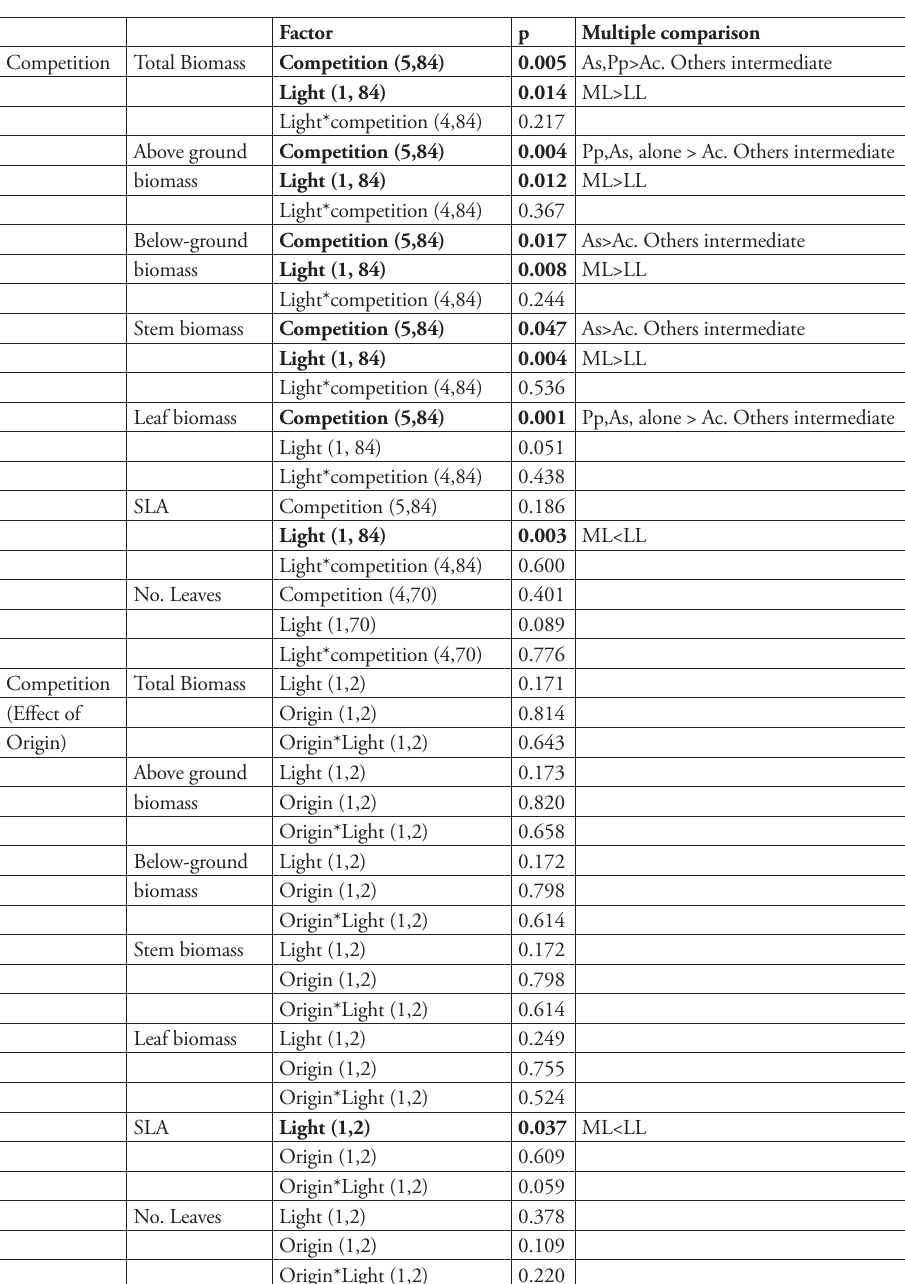
Table 1. Summary of p values of ANOVA tests investigating impacts of competition and light on growth for the tree, Guioa semiglauca . Degrees of freedom of tests are in brackets. Multiple comparisons (Tukeys Test) show where differences lie. Pp = Pandorea pandorana , As = Araujia sericifera, Ac = Anredera cordifolia. ML = medium light (33% PAR), LL = low light (10%